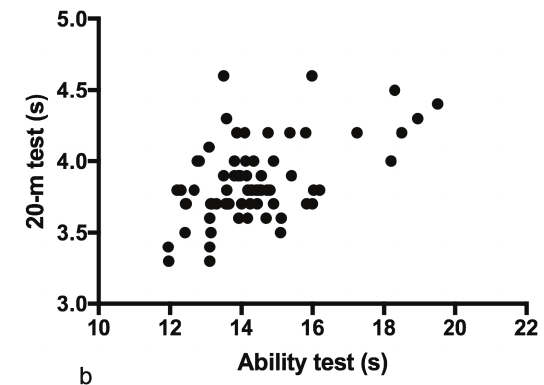
FIGURE 2. Correlation analysis between PAT and 20-m test (p<0.001). All data are in seconds.